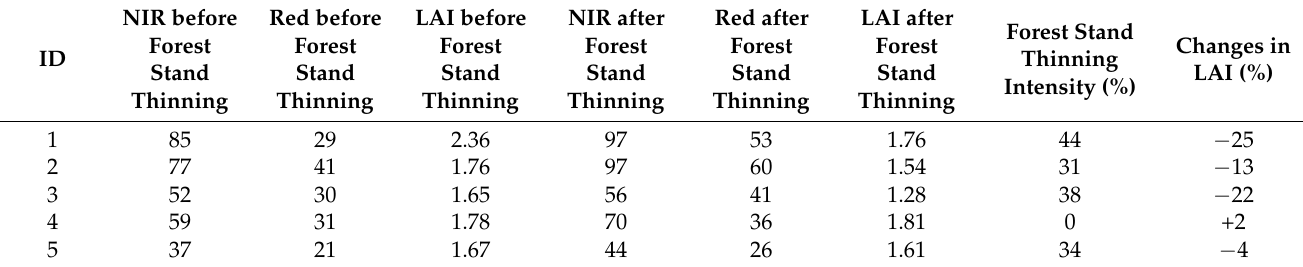
Table 3. Characteristics of the forest stands in the study plots.